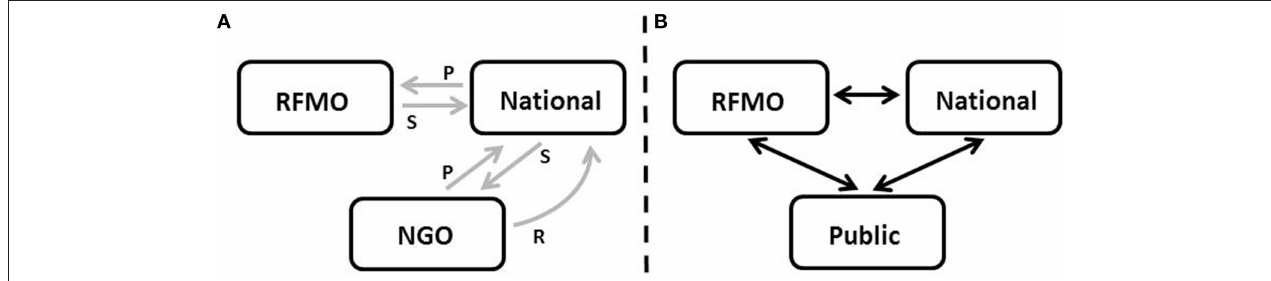
FIGURE 1 | Flows of data to detect and deter illegal, unreported and unregulated fishing. (A) The petitions for and supply of data described in the main text and summarized here. Given the lack of open access to fishery databases, the Costa Rican Fishing Federation, a non-government organization (NGO), petitioned regional fisheries data from the Costa Rican Ministry of Agriculture and Livestock, a national institution. Again, given the lack of shared databases, the Ministry asked the Inter-American Tropical Tuna Commission, a Regional Fisheries Management Organization (RFMO), for the regional data, received them, and then passed them to the NGO. The NGO analyzed the data and reported the potential cases of illegal fishing to the Ministry. However, the Ministry did not communicate the potential cases of illegal fishing back to the RFMO, and did not take action concerning the cases. (B) Preferable flow of data and information between RFMOs, national institutions, and the public (including NGOs, academia and civil society). Gray arrows in (A) represent deficient channels for sharing data (P indicates petition for data, S indicates supply of data, R indicates reporting on analyzed data). Solid arrows in (B) represent the idealized situation of formal and automatic channels for sharing